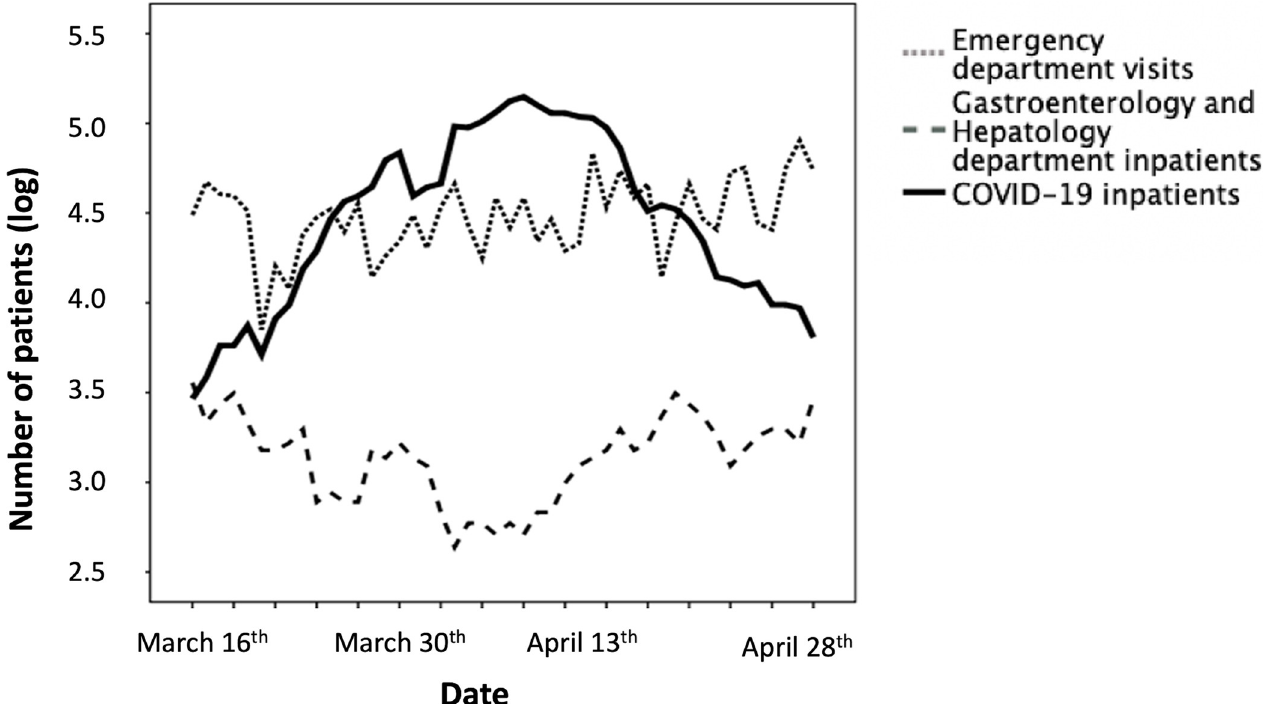
Fig 3. Burden on healthcare in our tertiary referral hospital during the COVID-19